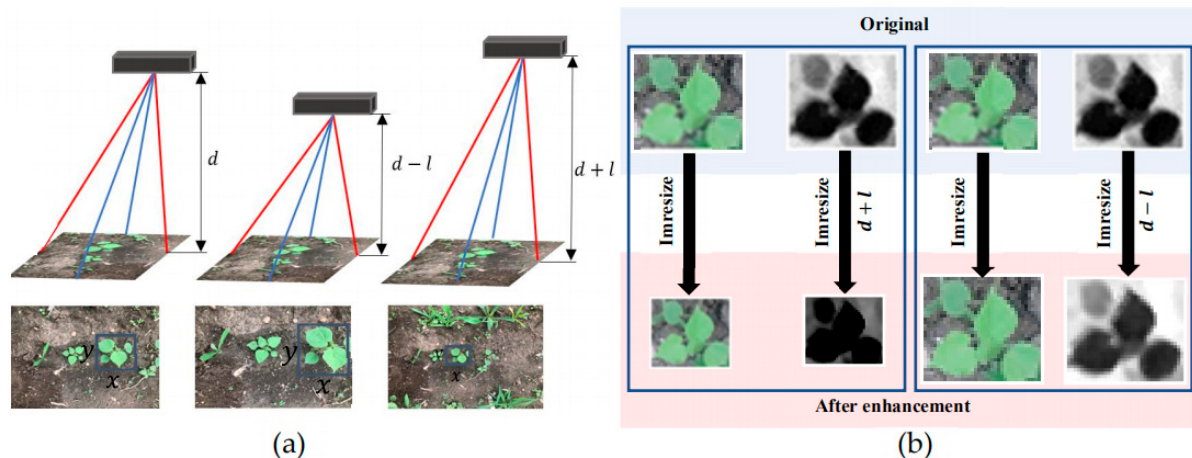
Figure 9. Schematic diagram of depth transformation enhancement. The parameters in the figure are consistent with Equations (5) and (6). ( a ) shows the effect of the picture in the high and low states. ( b ) the data in blue in the upper half represent the original data and the data in red in the lower half represent the enhanced data. The change in size of the RGB image can clearly be seen in the change. In value of the D matrix, the larger the value of the D matrix the darker the color.